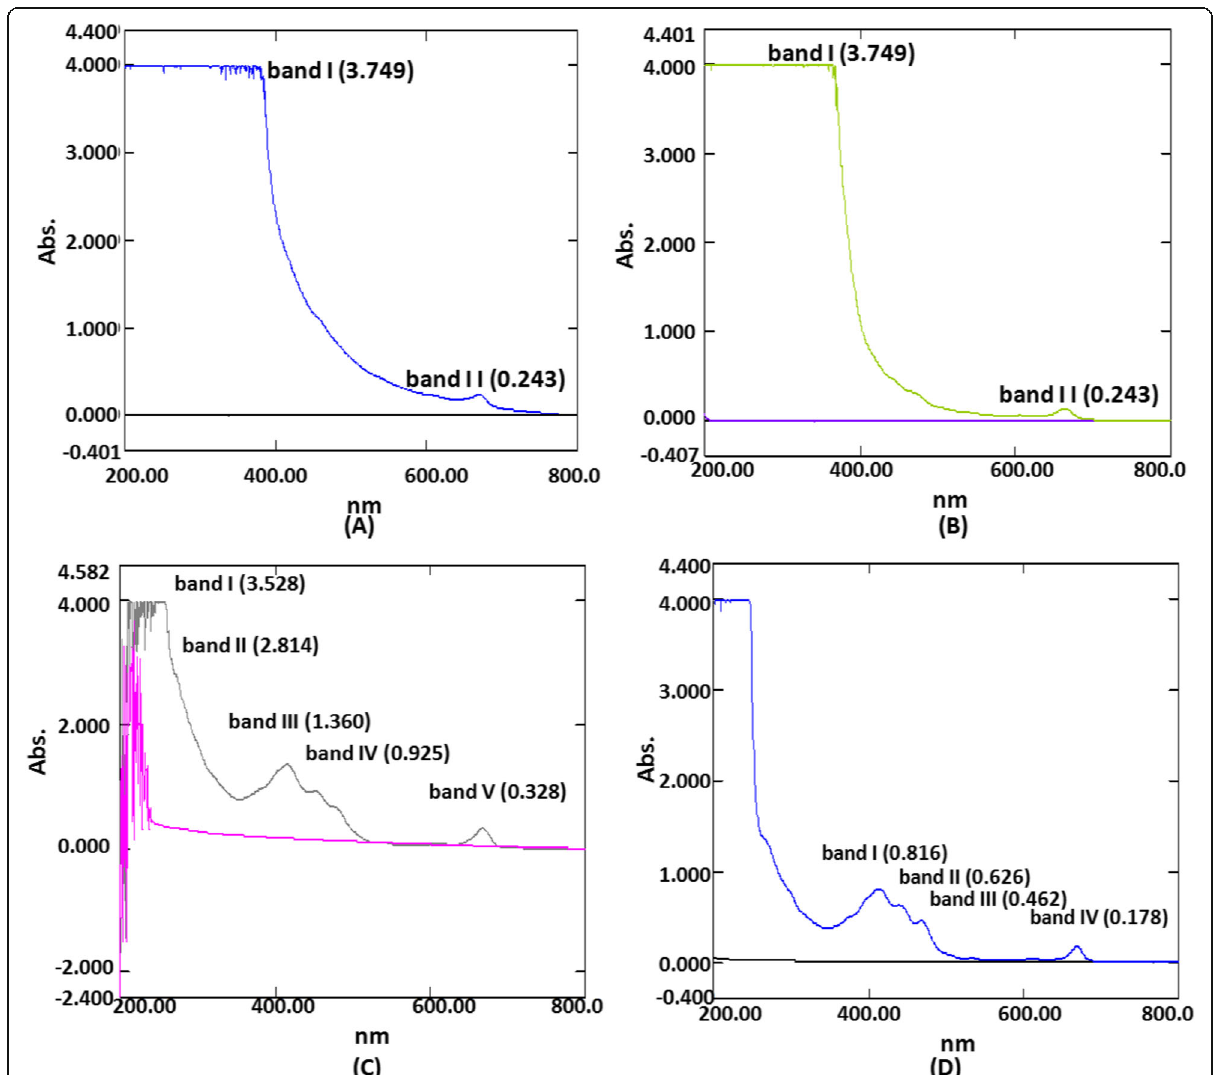
Fig. 2 UV-visible spectrum of fresh papaya flower extracts: aqueous ( a ), methanol ( b ), chloroform ( c ), and n -hexane ( d